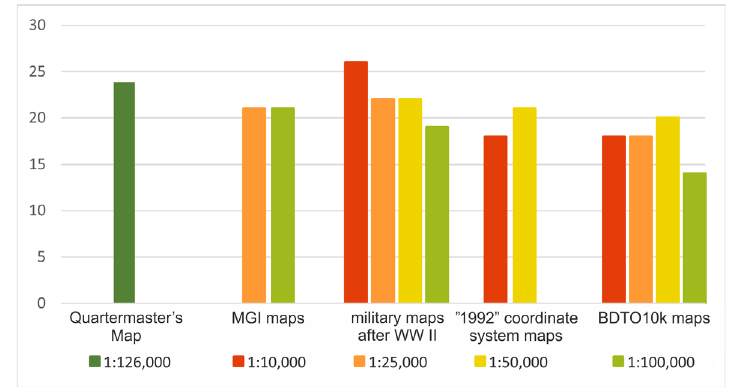
Fig. 7. Number of categories of content which belong to the built-up area